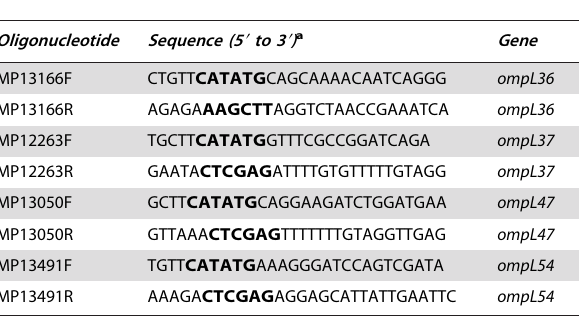
Table 1. Primers for amplification of new ompL